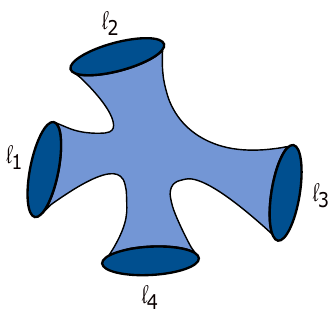
Figure 1 . Genus zero n -boundary loop amplitude (here n = 4